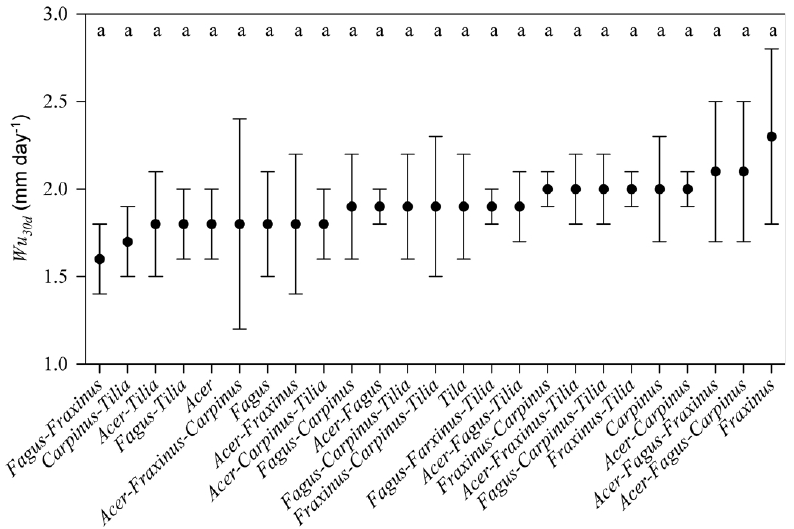
Figure 6. Wu 30d for all possible species combinations of Fagus , Tilia , Fraxinus , Acer and Carpinus during the soil desiccation period from 30 July to 1 September 2009. Values are means ± sd ( n = 4); same letters specify no significant di ff erence between species (LME and Tukey’s HSD).